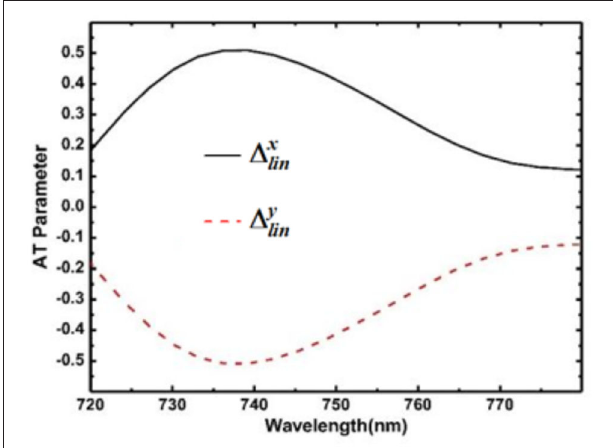
FIGURE 4 | The asymmetric transmission (AT) parameter for backward-propagating light.